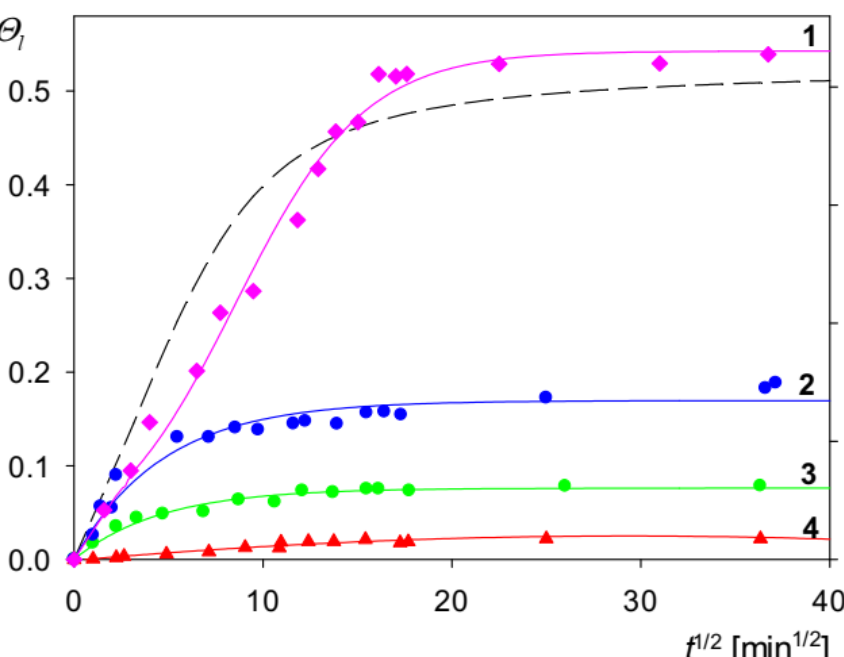
Figure 6. The kinetics of particle deposition on HSA layers determined by optical microscopy and AFM imaging for ionic strength 0.15 M, pH 5.5, bulk microparticle concentration 0.5% (5000 mg L − 1 ). The points denote the experimental data obtained for various HSA monolayer coverage adsorbed at pH 3.5 and ionic strength of 0.01 M: (1) ( (cid:7) ) N = 2 × 10 3 [ µ m − 2 ]; (2) ( • ) N = 7.5 × 10 2 [ µ m − 2 ]; (3) ( • ) N = 3 × 10 2 [ µ m − 2 ]; (4) ( (cid:78) ) N = 80 [ µ m − 2 ]. The solid lines are fits of experimental data and the dashed line shows the theoretical results calculated from the RSA model for positively charged particles of the size equal to 820 nm.